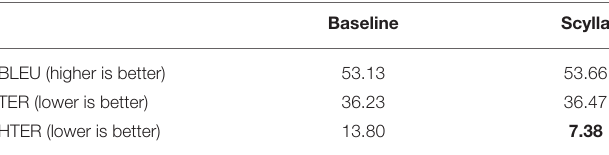
TABLE 2 | Evaluation of the baseline and Scylla systems for BLUE, TER, and